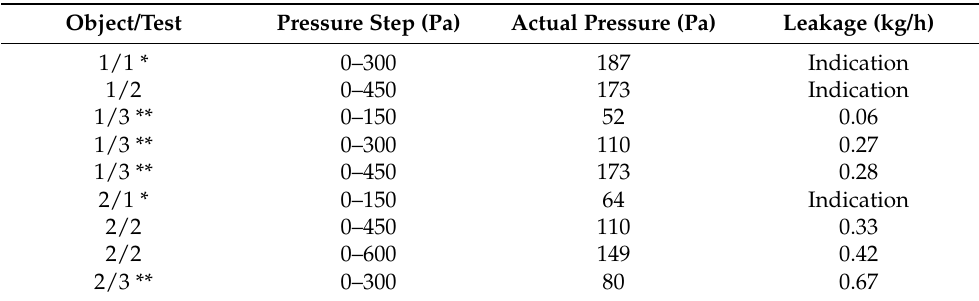
Table 6. Leakage in A19 from [19]. Two objects were studied in three testing rounds. The pressure steps according to the standard are given as well as the actual measured pressure over the joint sealing tape.